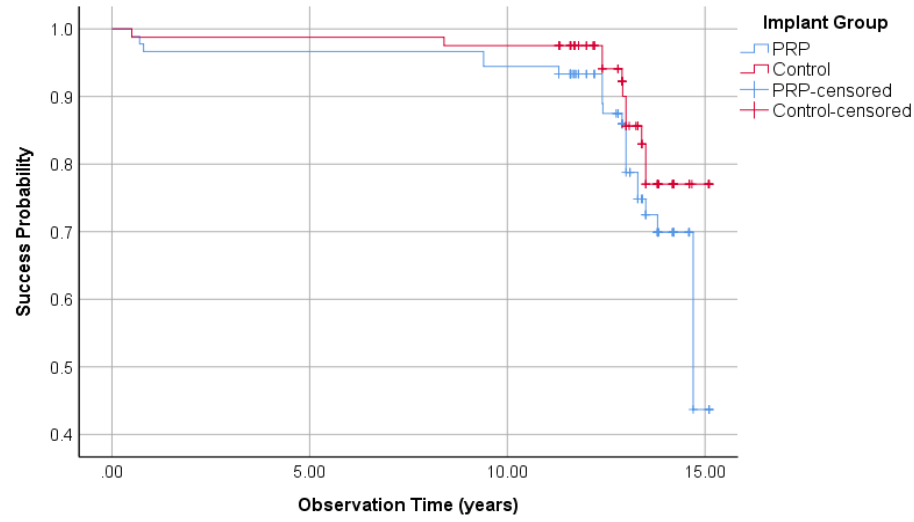
Figure 7. Kaplan–Meier success probabilities of 171 implants regarding the Albrektsson implant success criteria in the split-mouth evaluation.